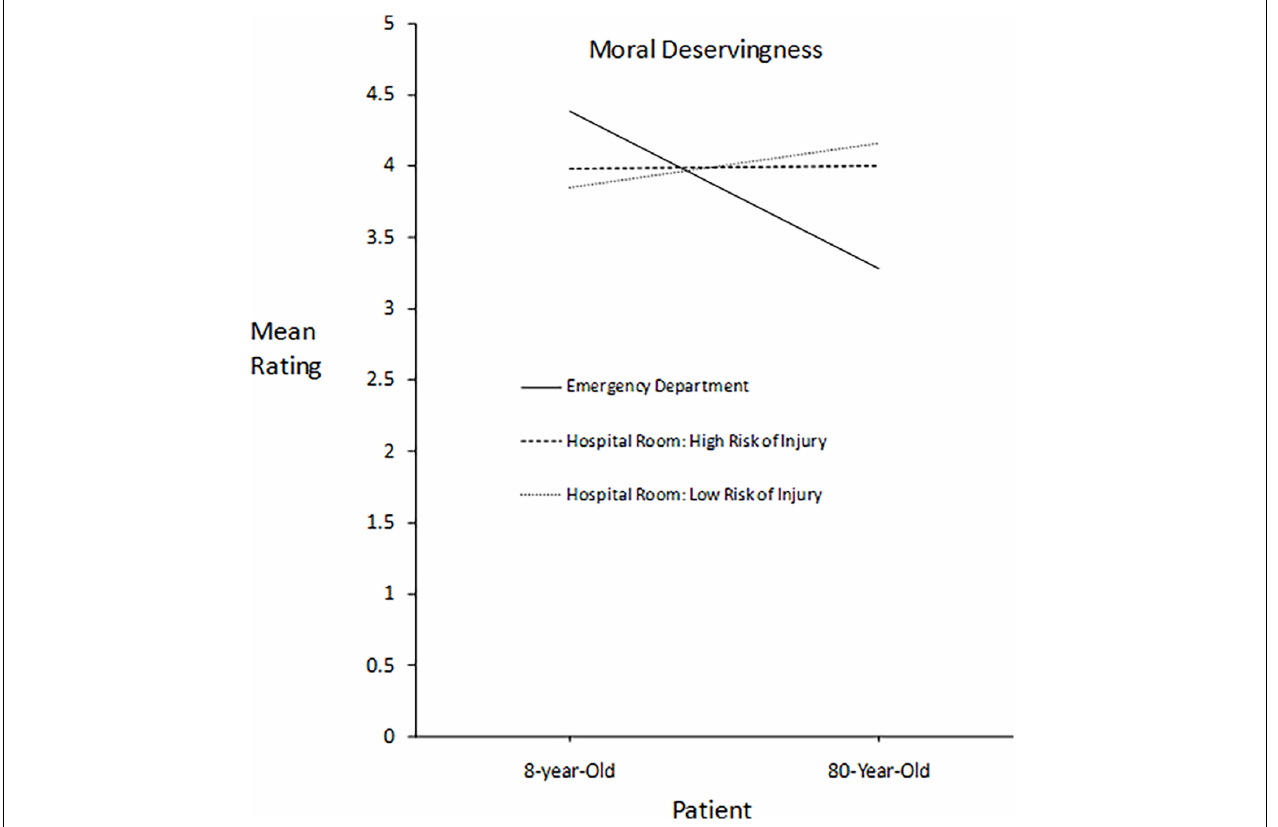
FIGURE 1 | For patients differing in age, participants’ mean ratings of each patient’s moral deservingness of immediate care in three settings differing in severity of risk to the patients: death, high risk of injury, and lower risk of